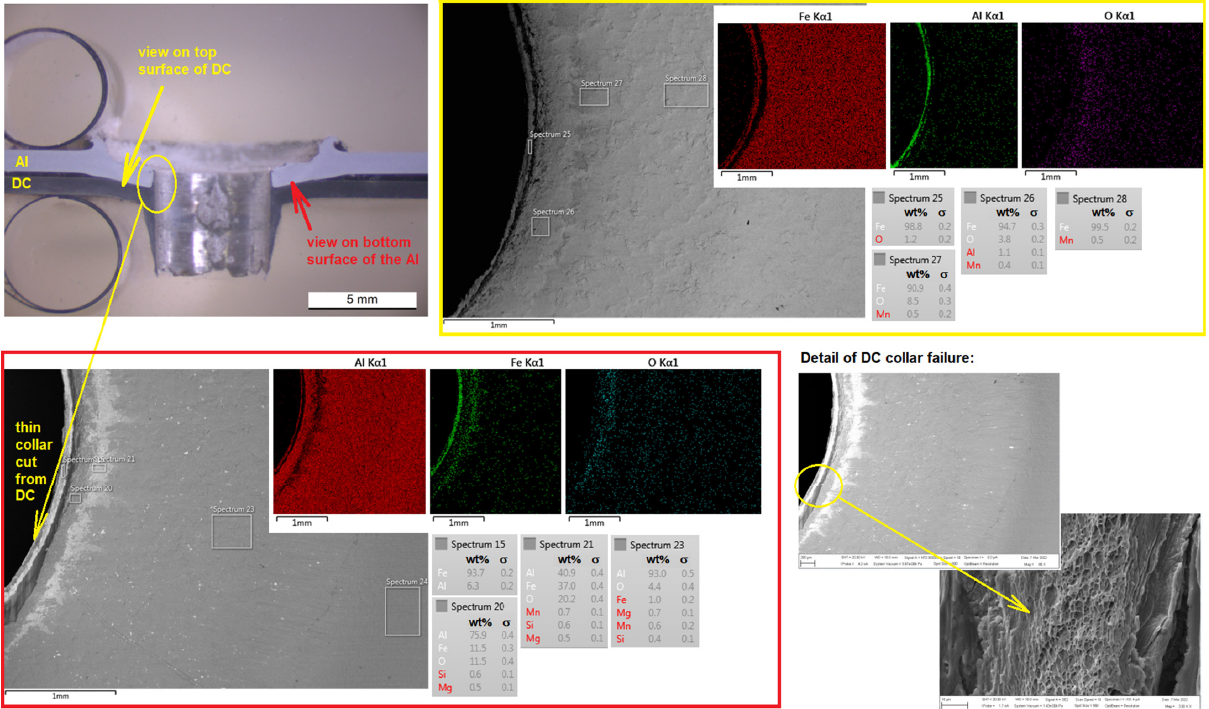
Figure 9. SEM analysis of Al-DC joint, element maps, EDS spectra, and fracture surfaces of bushing. The yellow border contains a detailed view on the top surface of the lower material. The red border contains a detailed view on the bottom surface of the upper material.